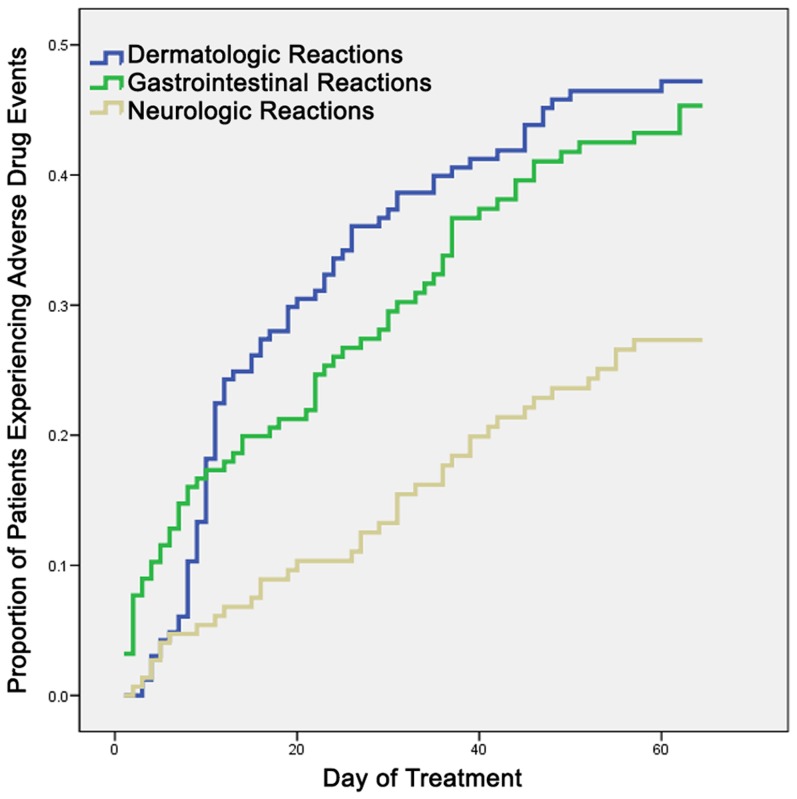
Timing of adverse drug events associated with benznidazole, by organ system.